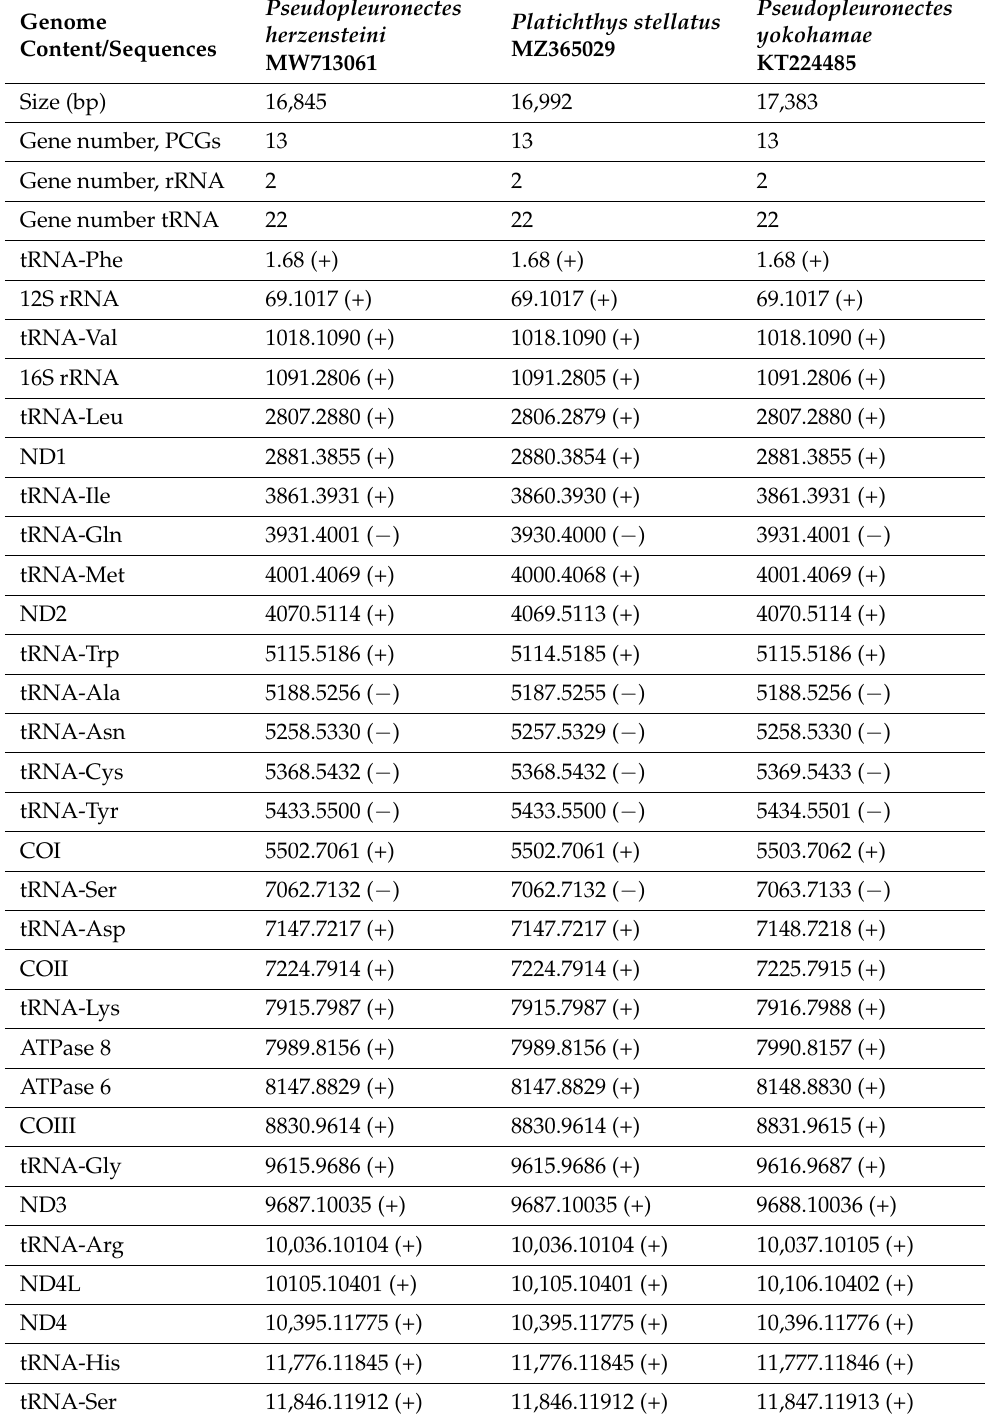
Table 2. Mitochondrial genome information on two flatfish sequences presented in the current paper ( P. herzensteini and P. stellatus ) and the third ( P. yokohamae ), retrieved from